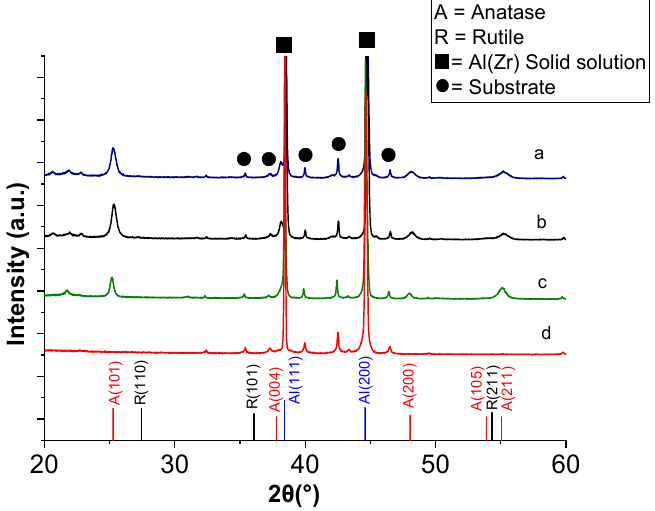
Figure 4. XRD patterns for TiO 2 films deposited at ( a ) 550 °C, ( b ) 540 °C, and ( c ) 500 °C on ( d ) Al–Zr.